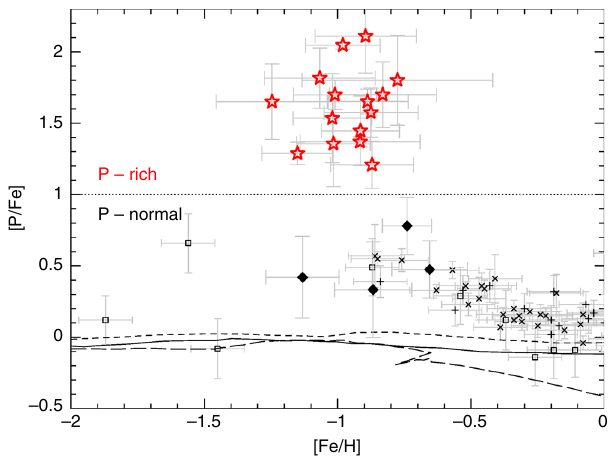
Fig. 1 Phosphorus abundances as a function of metallicity. Red stars and black diamonds show, respectively, the P-rich and P-normal stars analyzed in this work. Error bars represent measurement uncertainties such as shown in Supplementary Tables 2 and 4. The P-normal stars are the group of comparison (twins) stars with very similar stellar parameters to the P- rich ones but with a chemical abundance pattern similar to fi eld stars (see Methods: Chemical abundance analysis). The dotted line shows the empirical de fi nition adopted here to distinguish the P-rich stars from the P- normal ones. Open squares, crosses, and plus signs are literature values from ref. 8 , ref. 13 and refs. 11,12 , respectively. The long-dashed line shows the chemical evolution model from ref. 5 , short-dashed line from ref. 6 and solid line from ref. 7 Error bars have been adopted from same